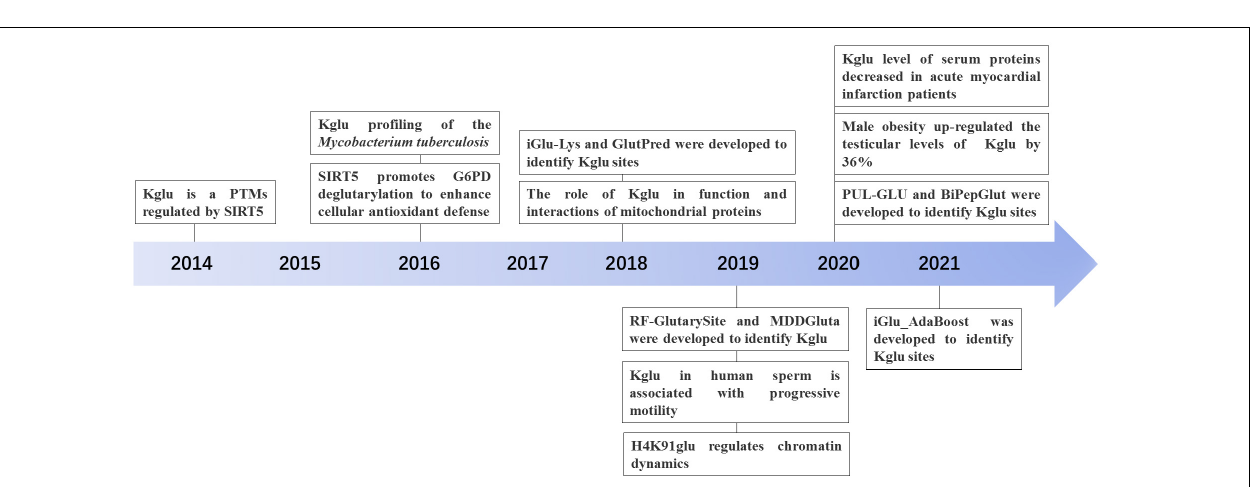
FIGURE 2 | The discovery and development history of Lysine glutarylation